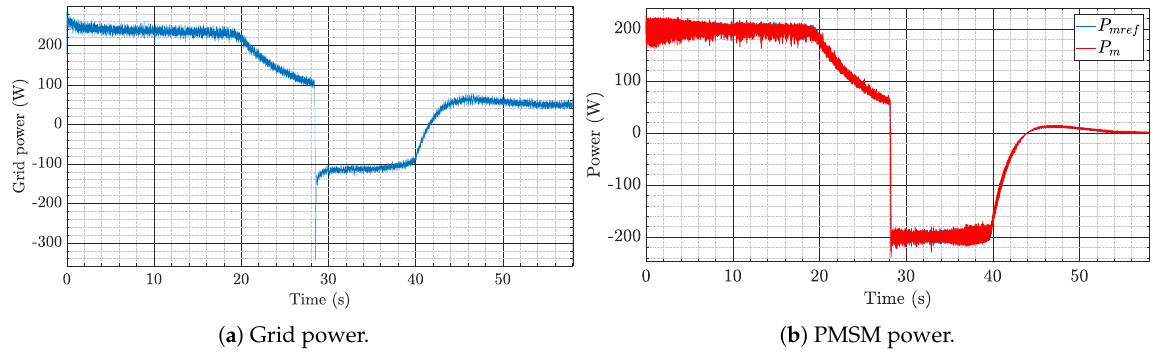
Figure 16. Experimental results with power regulation.